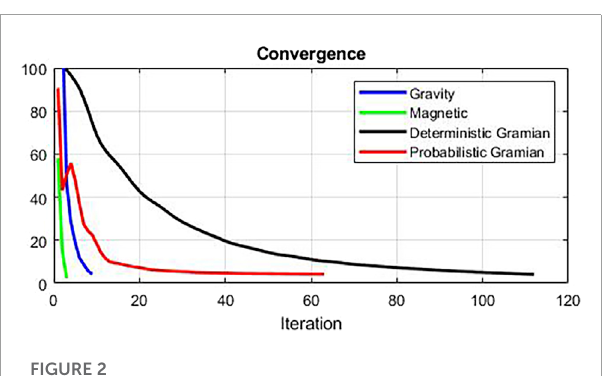
FIGURE 2 Convergence comparison shown as data misfit versus iteration number. The standalone gravity and magnetic inversions are shown by the blue and green lines, respectively. The deterministic and probabilistic Gramian inversions are shown by the black and red lines,